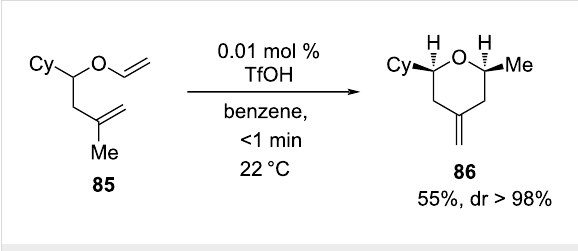
Scheme 18: Mechanism for the Lewis acid-catalyzed synthesis of tetrahydropyran-4-one.